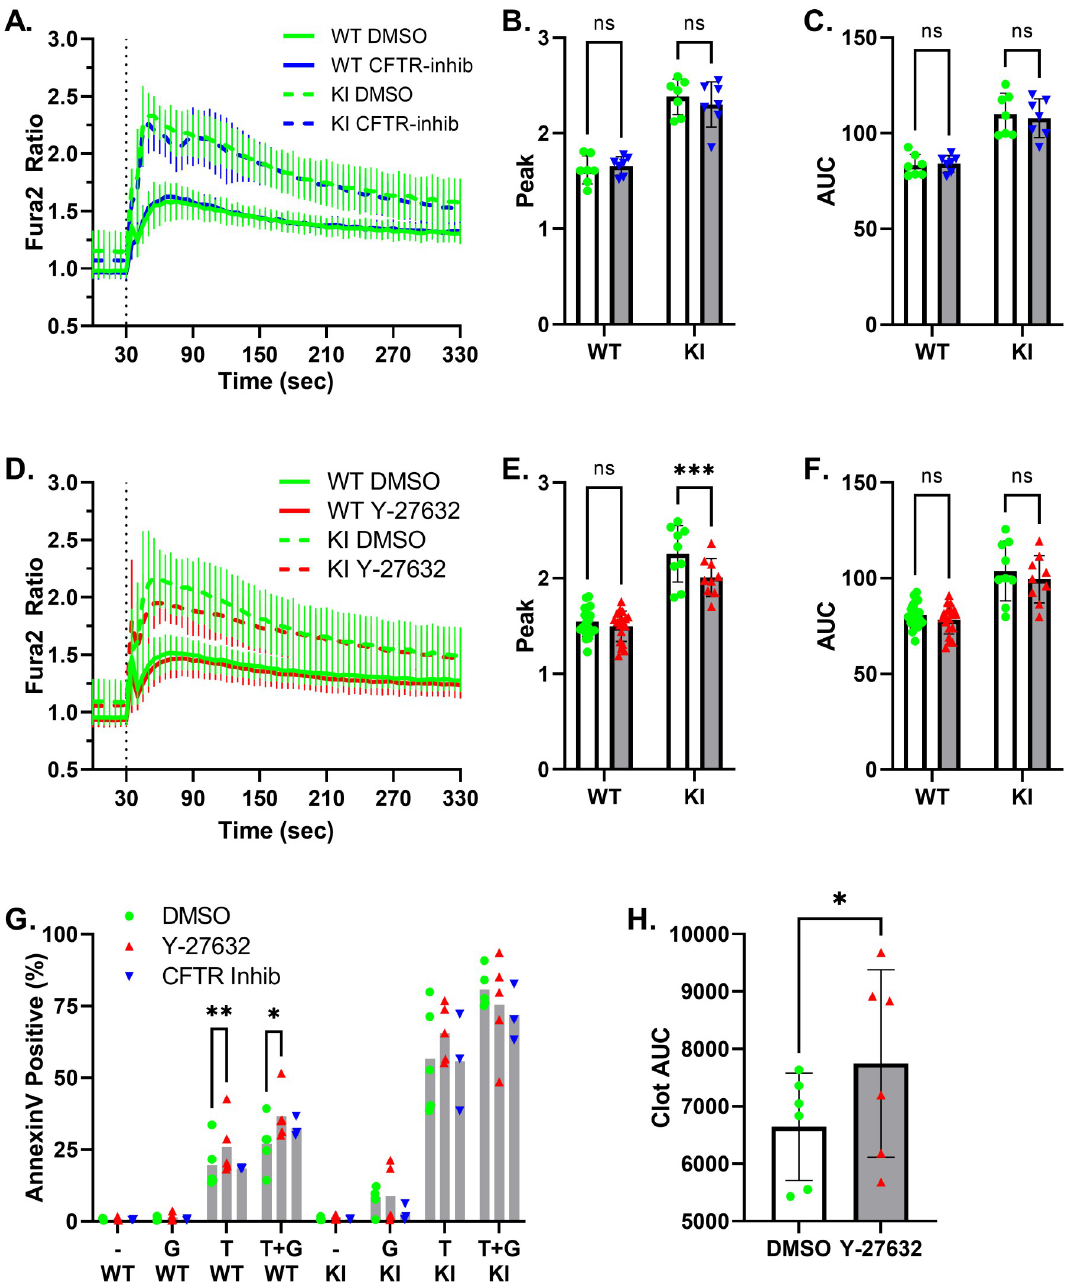
Fig 8. Effect of CFTR and ROCK inhibition on TRPC6-mediated platelet responses. A-C, WT and KI platelets, pre-incubated in the presence of vehicle (DMSO) or CFTR-inhibitor 172 (3 μ M) for 15 minutes, were subject to Fura-2 ratiometric imaging. GSK was added after 30 seconds. A, Fura-2 fluorescence ratio (340/380) time-course; n = 7. The post-stimulation Fura-2 fluorescence ratio peak (B), and area under the curve (C), are shown. Two way ANOVA with Sidak’s multiple comparisons test. D-F, WT and KI platelets, pre-treated with ROCK inhibitor Y-27632 (10 μ M) or vehicle for one hour, were subject to Fura-2 imaging and GSK stimulation. Shown are the time-course (D), peak ratio (E), and area under the curve (F); n = 9–19. Two way ANOVA with Sidak’s multiple comparisons test. G, percentage of Annexin V stained platelets from WT and KI mice, pretreated with vehicle (DMSO), Y27632, or CFTR-inhibitor, followed by stimulation with vehicle (-), GSK (G), thrombin (T), or thrombin plus GSK (T+G); n = 3–5. Mixed effects analysis with Dunnett’s multiple comparisons test; only statistically significant pairwise comparisons are shown. H, platelet-rich plasma was incubated with vehicle (DMSO) or Y-27632, and clot retraction observed. Clot area under the cure (AUC) was calculated by summing the clot areas across all time-points for each sample; paired